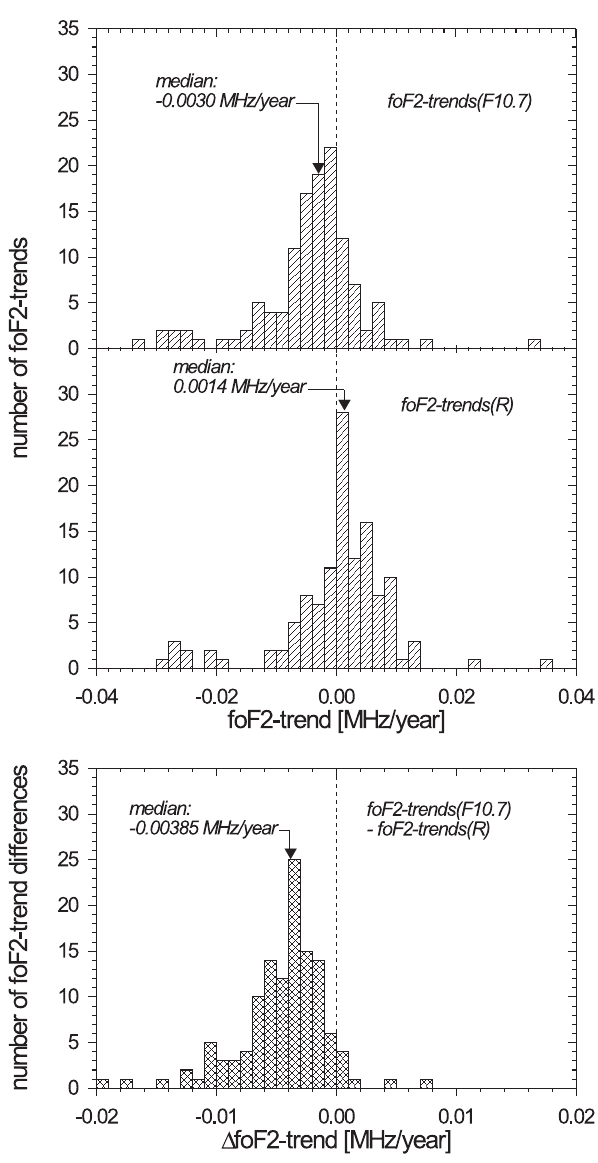
Fig. 6. Histograms of fo F2 trends by use of F10.7 or R data in the trend analyses (upper part) as well as a histogram of the differences of both fo F2 trends (lower part). The corresponding median values are marked by arrows.